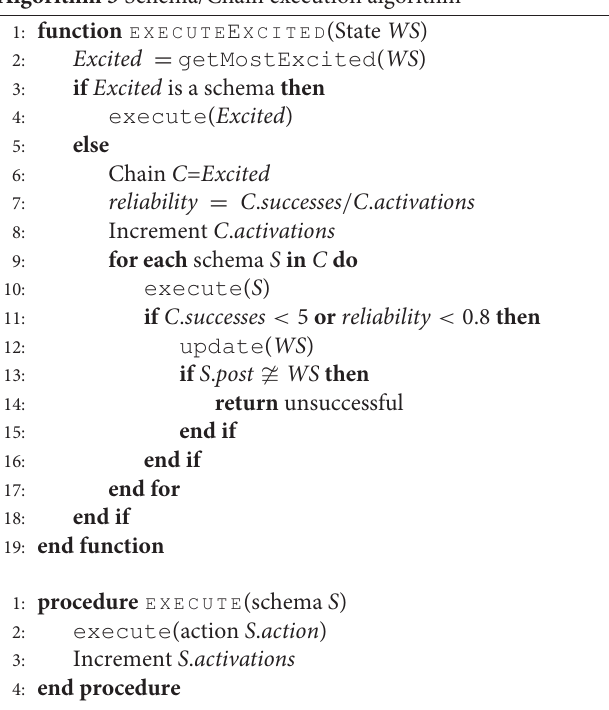
Algorithm 3 Schema/Chain execution